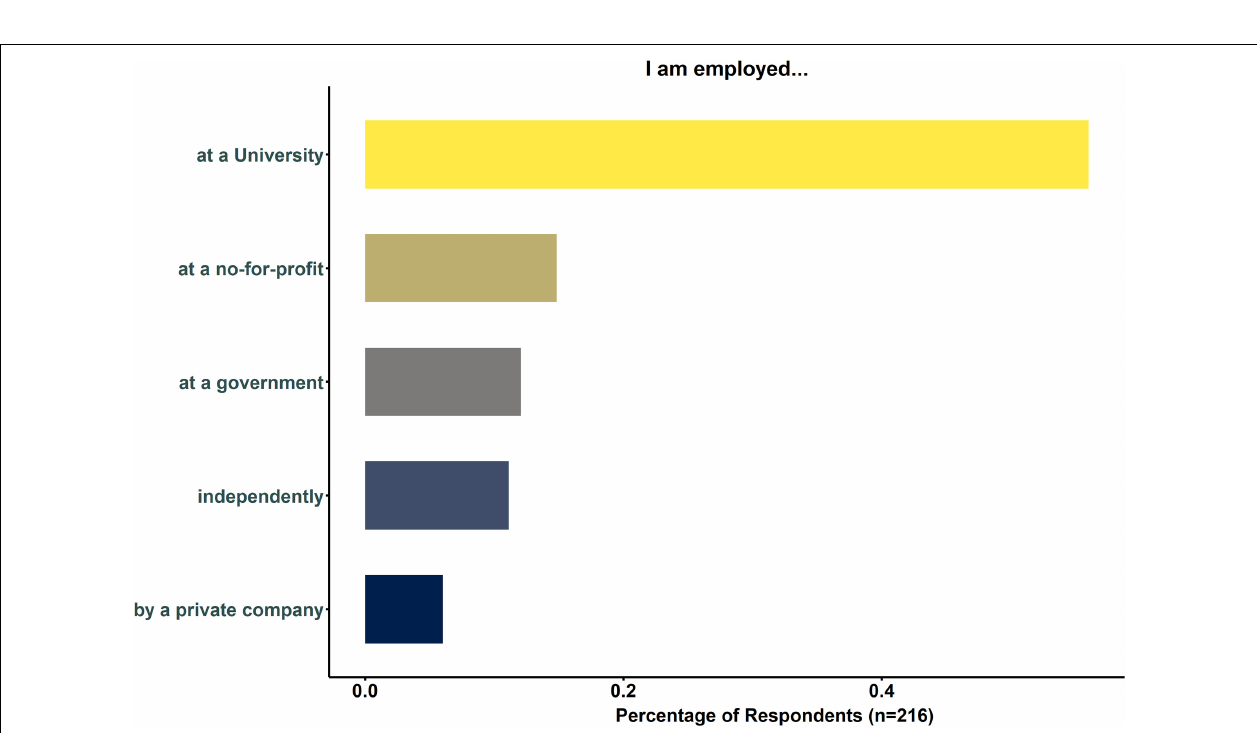
Frontiers in Forests and Global Change |